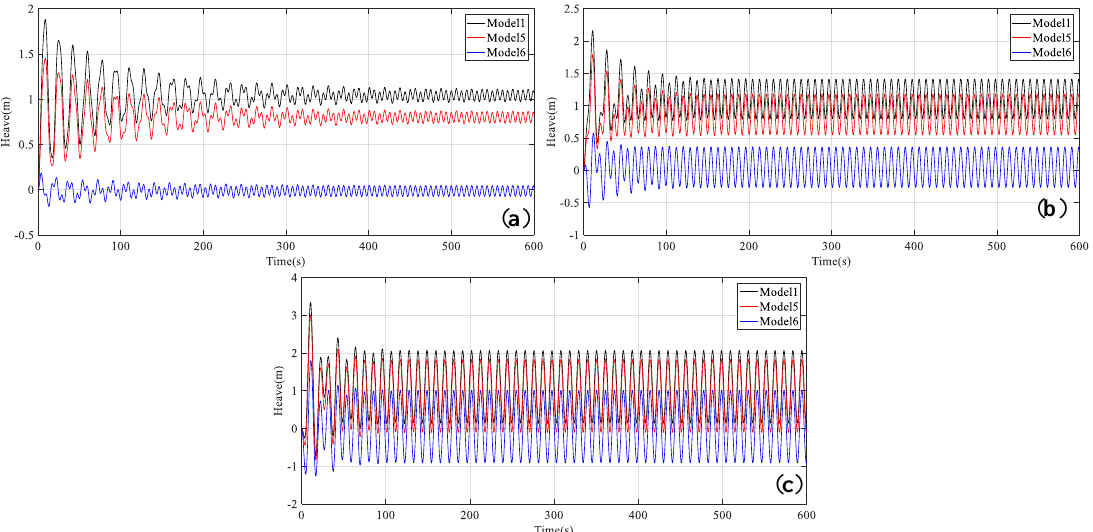
( b ) LC2; and ( c ) LC3. Energies 2019 , 12 , x FOR PEER REVIEW LC2; and ( c ) LC3.